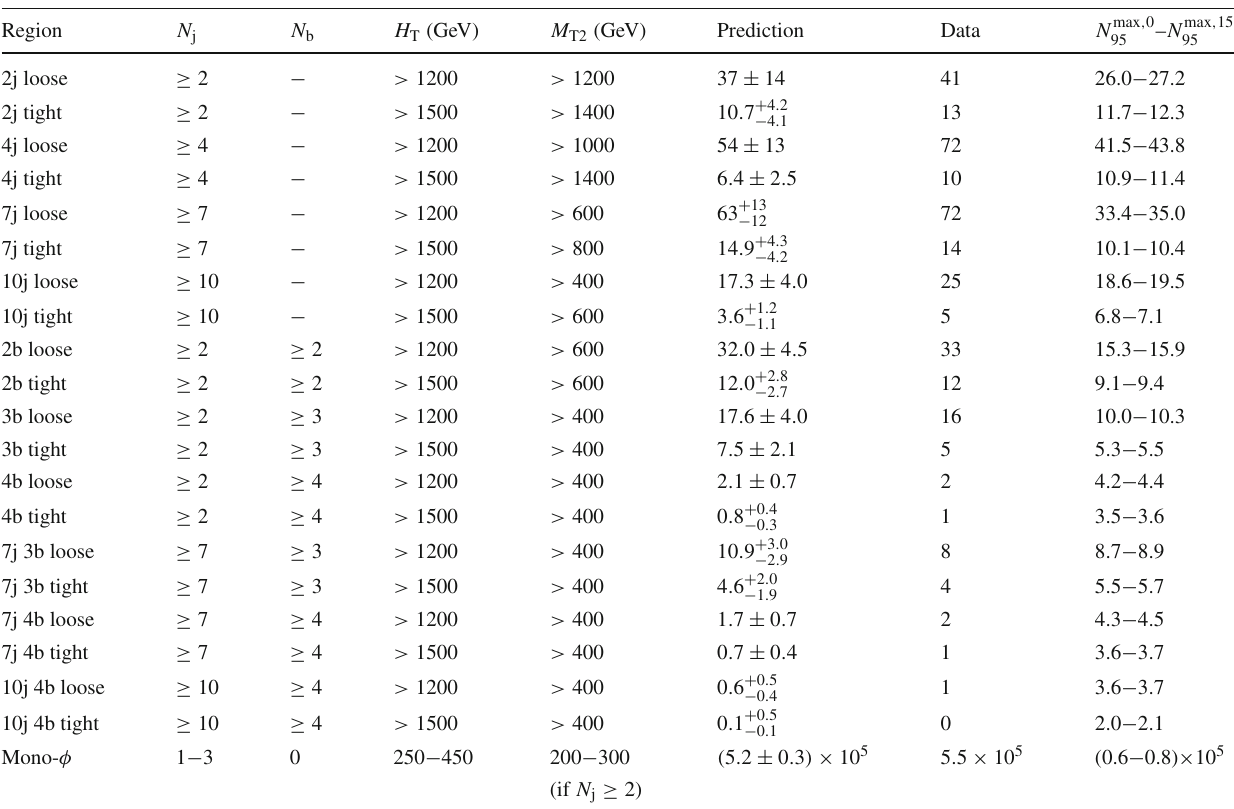
Table 6 Definitions of super signal regions, along with predictions, means that no requirement is applied. All selection criteria as in the full observed data, and the observed 95% CL upper limits on the number of analysis are applied. For regions with N j = 1, H T ≡ p jet signal events contributing to each region ( N max ). The limits are shown super signal region corresponds to the subset of analysis bins identified 95 as a range corresponding to an assumed uncertainty in the signal accep- in Refs. [35,36] as showing a significant excess in data based on the – N max , 15 ). A dash in the selection criteria tance of 0 or 15% ( N max , 0 results of Ref. [9] 95 95